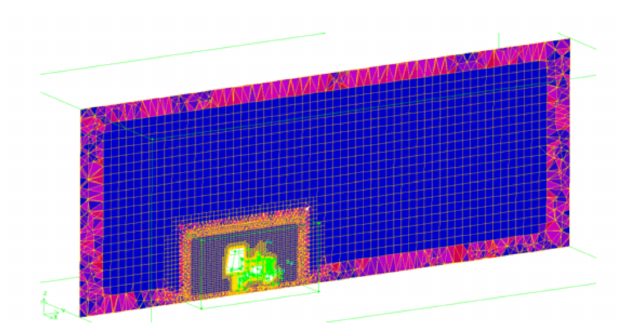
Figure 2. Simplified engine compartment.